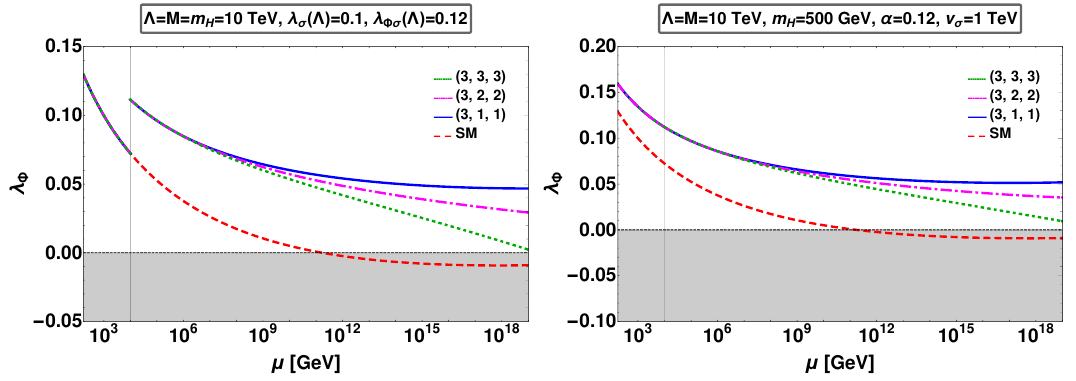
Figure 10 . Comparing the evolution of the quartic Higgs self-coupling λ in the Standard Model (dashed, red) with various inverse-seesaw extensions with explicit lepton number violation: (3,1,1) denoted in solid (blue), (3,2,2) dot-dashed (magenta) and (3,3,3) dotted (green), see text for details.